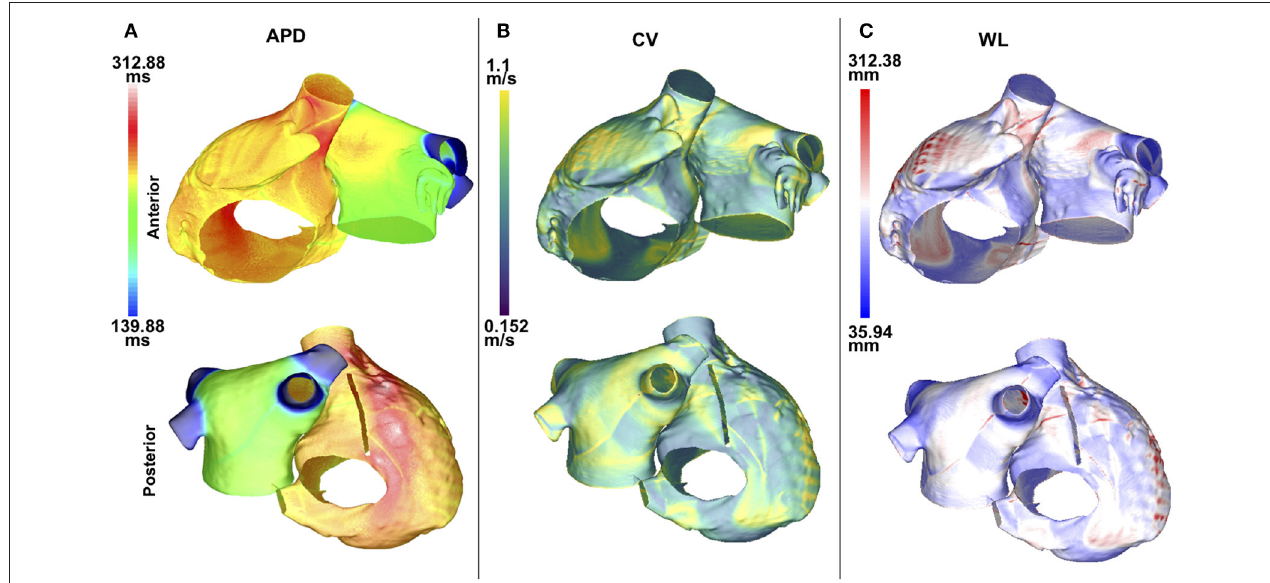
FIGURE 2 | APD, CV, and WL maps are spatially heterogeneous in the control case without fibrosis. Anteroposterior (top row) and posteroanterior (bottom row) views are shown. (A) APD90 map. (B) CV map. (C) WL map. Data are displayed on a reduced mesh for 80 % I K 1 .